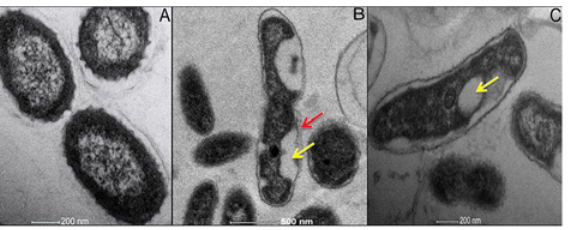
Fig 4. Internalization of NPs with Transmission Electron Microscopy: (A) The intact bacterial consortium, (B) Consortium interacted under dark condition showing disrupted morphology and vacuole formation, and (C) Interacted consortium cell under UVA condition depicting the vacuole formation. Notations used: Red arrow represents the distortion of the cell and yellow arrow denotes the formation of vacuoles.